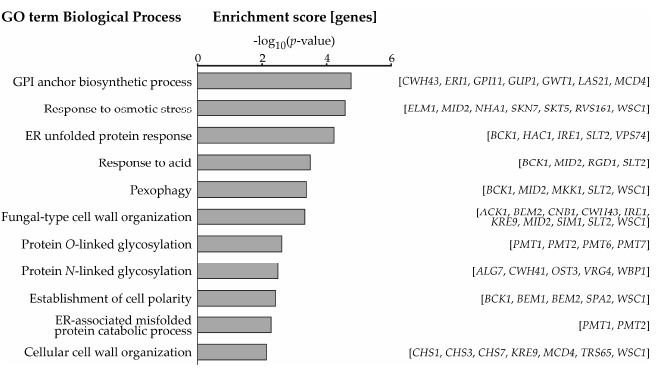
Figure 1. Functional categories enriched ( p -value < 0.01) among mutants hypersensitive to protein O -mannosyltransferase-inhibitor R3A-5a. Gene ontology (GO) term analysis was performed using GeneCodis applying default settings. Genes assigned to the respective biological process are listed in square brackets. GPI—glycosylphosphatidylinositol. ER—endoplasmic reticulum. Table 1. List of genes assigned to a particular biological process after manual verification using the Saccharomyces Genome Database.